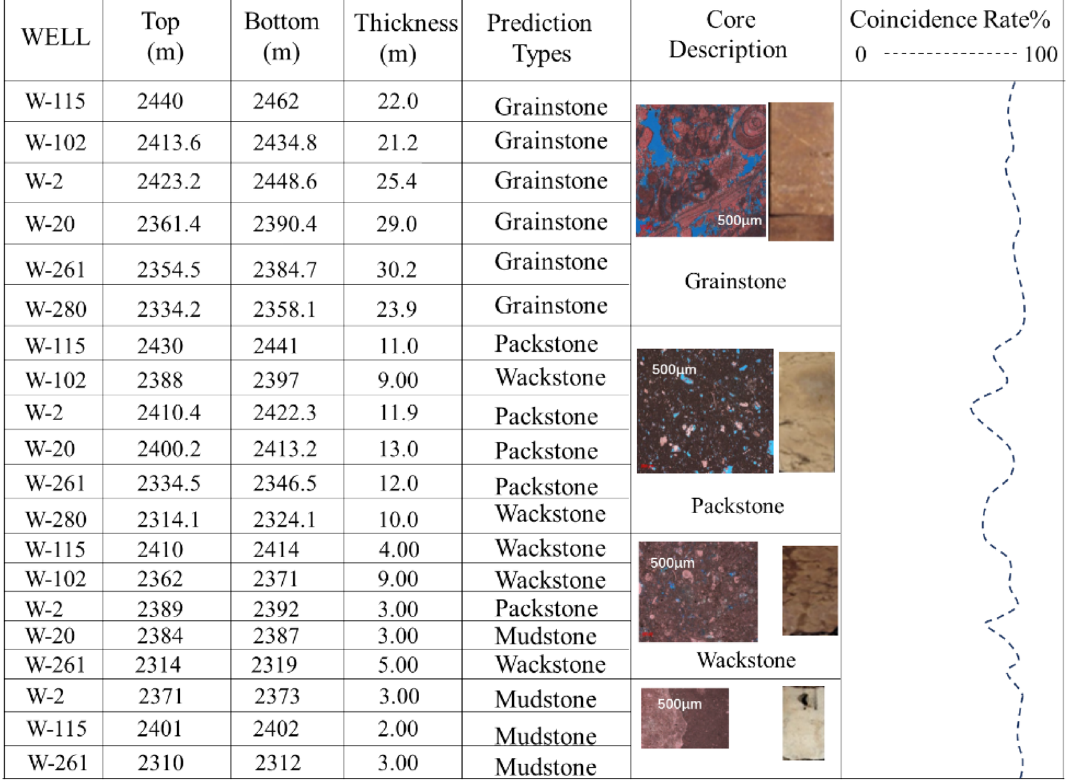
Figure 6. Test results of discriminant model for examined samples.